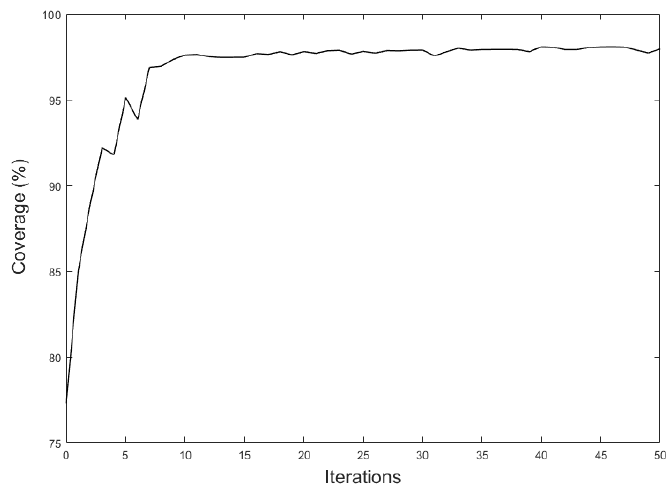
Figure 11. Camera coverage convergence diagram for the 3D Voronoi approach in 50 iterations.